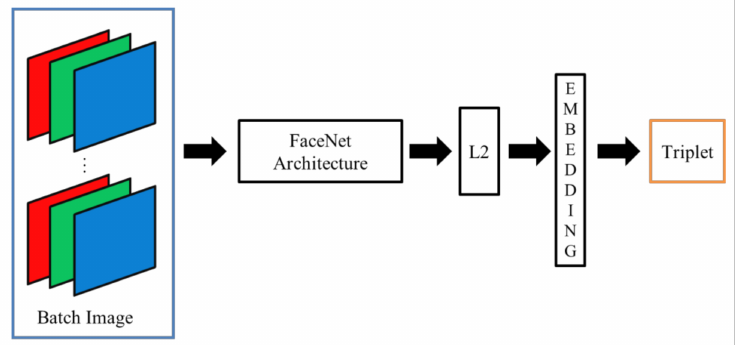
Figure 3. Block diagram of FaceNet architecture.